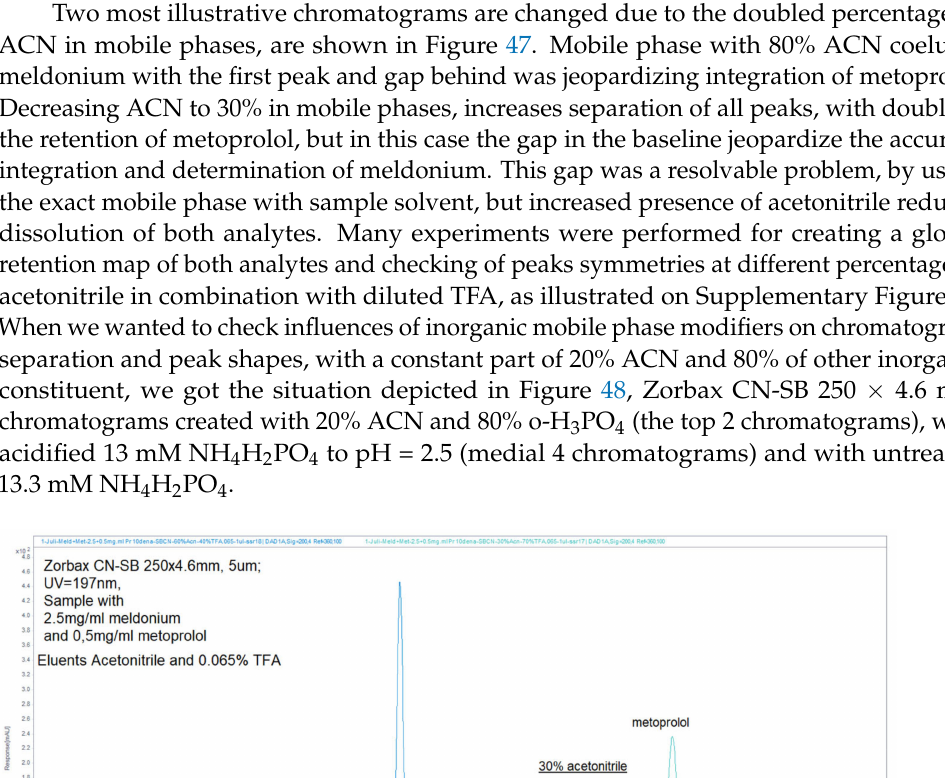
Figure 46. Chromatograms, obtained by increasing ACN to 80%, guided the appearance of chro- matogram with a slightly increased retention, appearing on new non separated peaks of unknown and meldonium, separated metoprolol peak, and with a negative peak on the baseline eluting right behind metoprolol, jeopardizing this peak accuracy definition.